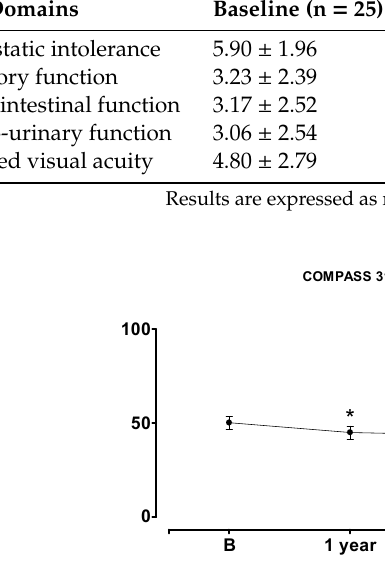
Table 6. VAS autonomic symptom assessment comparison between baseline and 1-year follow-up.